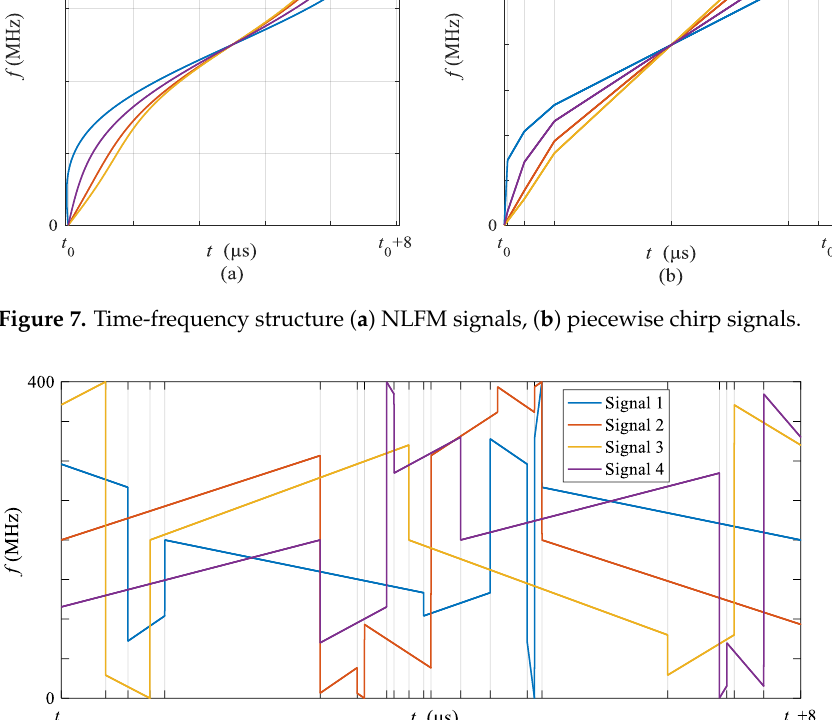
obtained by the proposed algorithm. tained by the proposed algorithm.